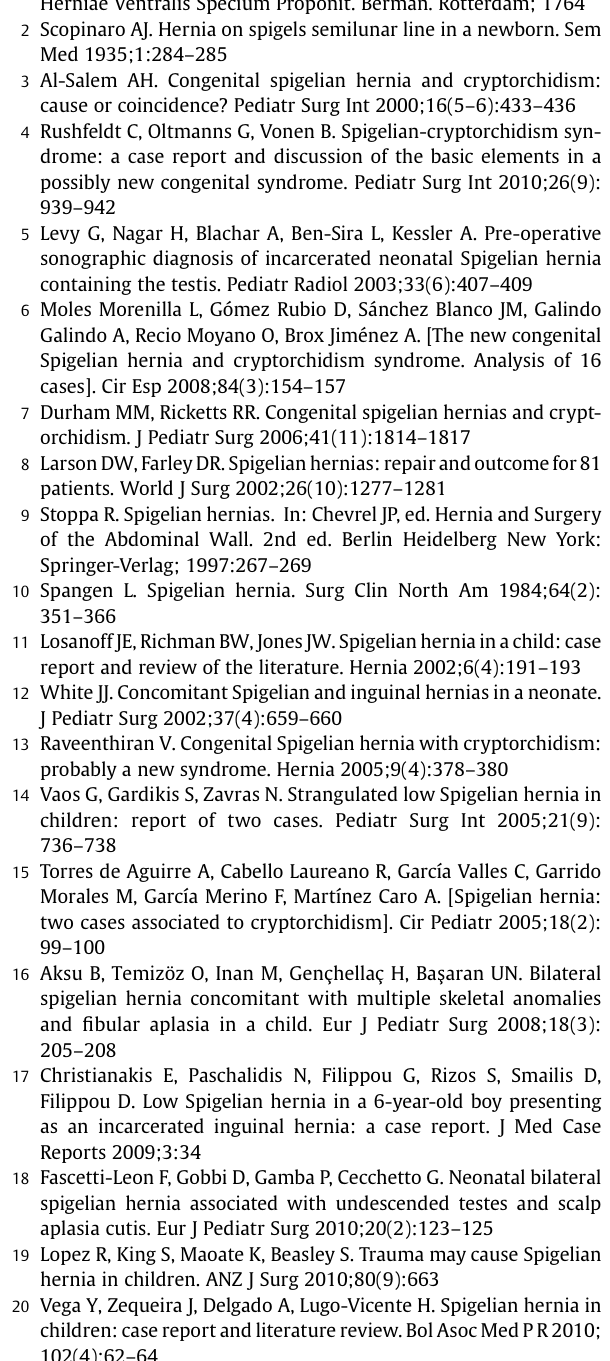
Table 2 Main features of Spigelian hernia (cid:129) Congenital or acquired defect of Spigelian fascia, located between the rectus abdominis muscle medially and the semilunar line laterally. (cid:129) The external oblique fascia is generally intact. (cid:129) The hernia sac is located between the internal oblique muscle and aponeurosis of the transversus muscle and contains mostly preperitoneal fat, small intestine, colon, and omentum. (cid:129) SH can be associated with cryptorchidism; in most of these cases, the undescended testis is located in the hernia sac. (cid:129) Often asymptomatic; symptoms and signs ranging from pain, swelling, intermittent abdominal pain to acute abdomen. (cid:129) Differential diagnosis with appendiceal abscess, ventral or inguinal hernia, tumor of the abdominal wall, spontaneous hematoma of the rectus sheath. (cid:129) SH in children is small and has to be repaired because of a high risk of incarceration: open surgery is the technique of choice. Abbreviation: SH, Spigelian